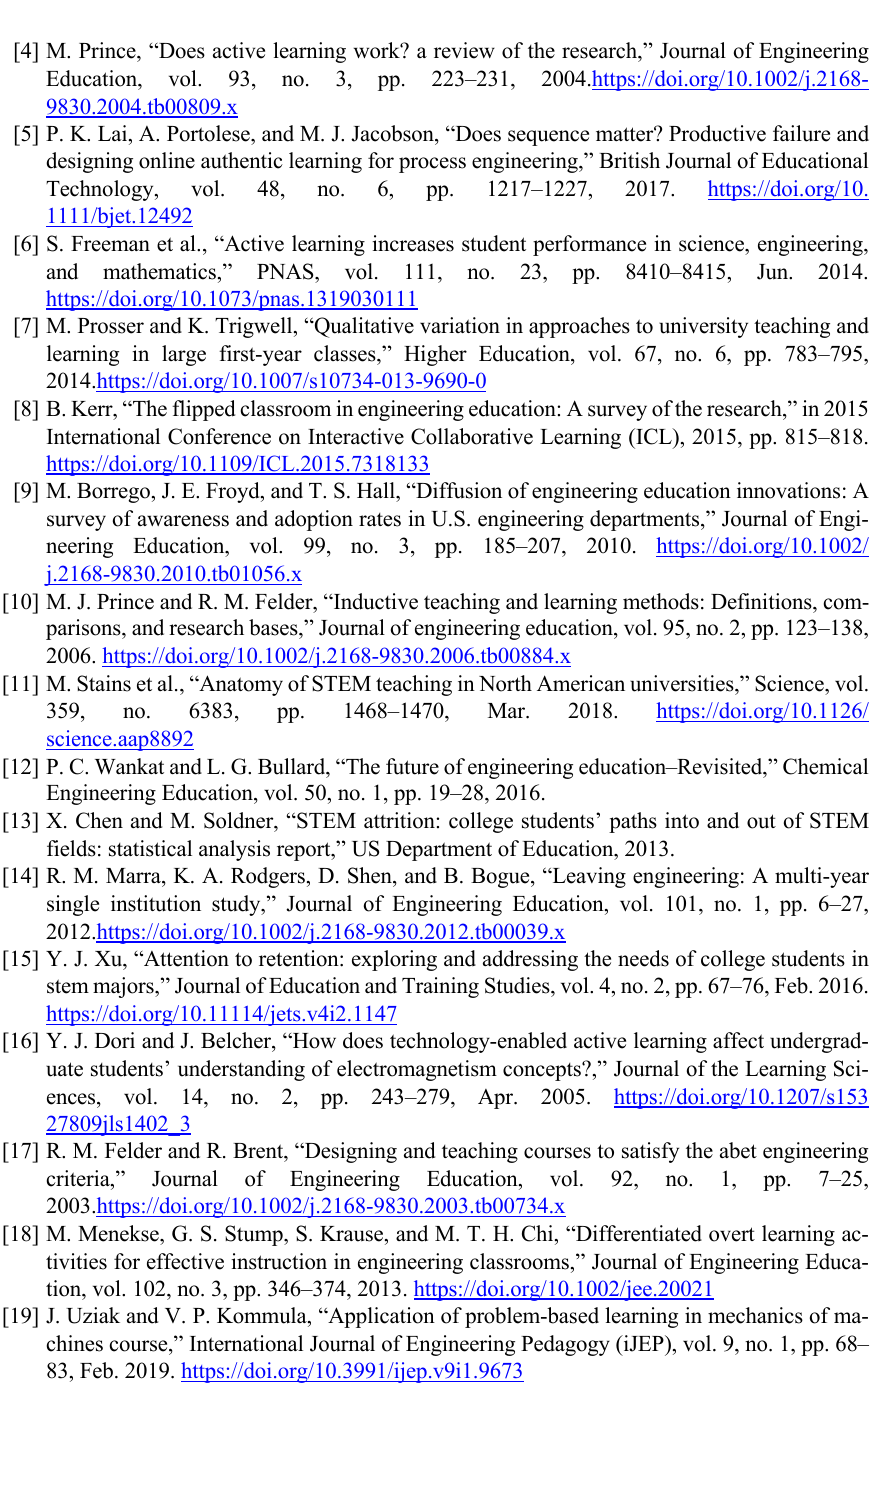
Paper —Defining Open-Ended Problem Solving Through Problem Typology